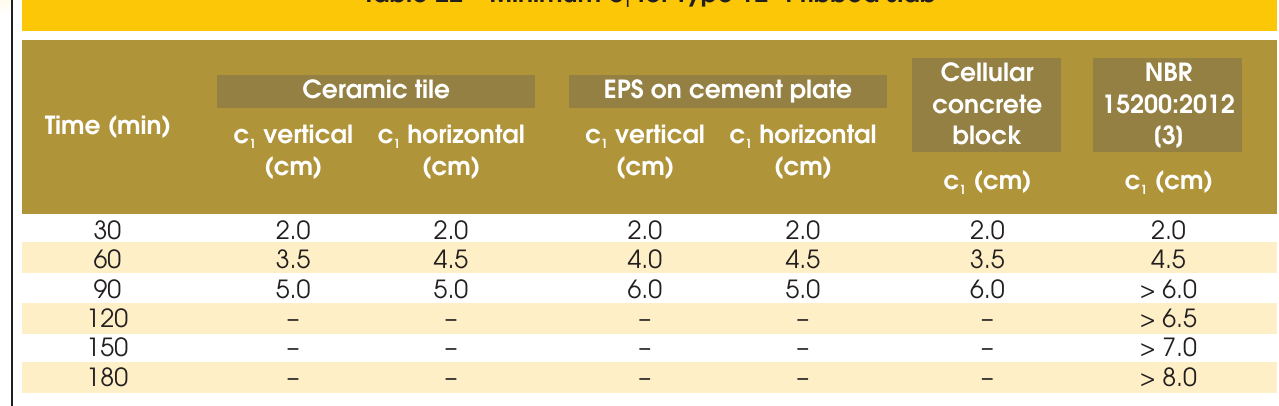
Table 22 – Minimum c for Type 12-4 ribbed slab